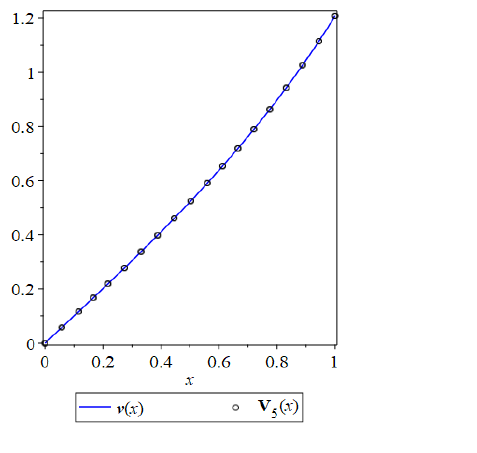
( a ) ( b ) Figure 1. ( a ) A comparison between the exact solution υ ( x ) and the series solution V 5 ( x ) ; ( b ) absolute error | υ ( x ) − V 5 ( x ) | Figure 1. ( a ) A comparison between the exact solution ( ) x υ and the series solution ( ) ( ) ( ) x x − υ V . 5 Table 2. A comparison between the numerical results of ( ) x υ and ( ) x ( ) υ x ( )